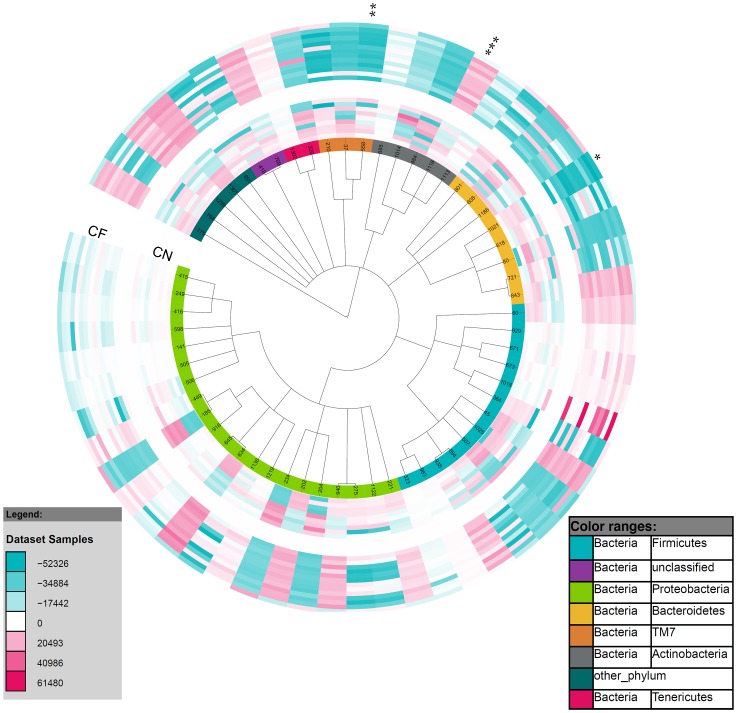
Taxa of differential abundance between the control and CF lower airway.Circular Phylogenetic Tree was rendered in iToL and illustrates abundance changes between eOTUs present in the control lower (inner ring) and CF lower (outer ring) airways. The colour saturation indicates the degree of difference from the mean control lower value for the eOTU; where dark blue indicates a HybScore difference of −52326, white  = 0 (no change from mean control lower), dark red  = +61480. Two eOTUs remained of significantly differential abundance following Benjamini-Hochberg correction; Prevotella veroralis (*) and a CW040 (**). Following a permutation test, 62 taxa were found to be of significantly differential abundance, Corynebacterium (***) is highlighted. A detailed list of the 59 taxa of significantly differential abundance between categories is provided in the supplementary data (S2 File).